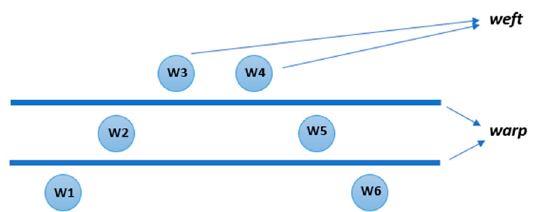
Figure 3. Shifted model of wert insertion.